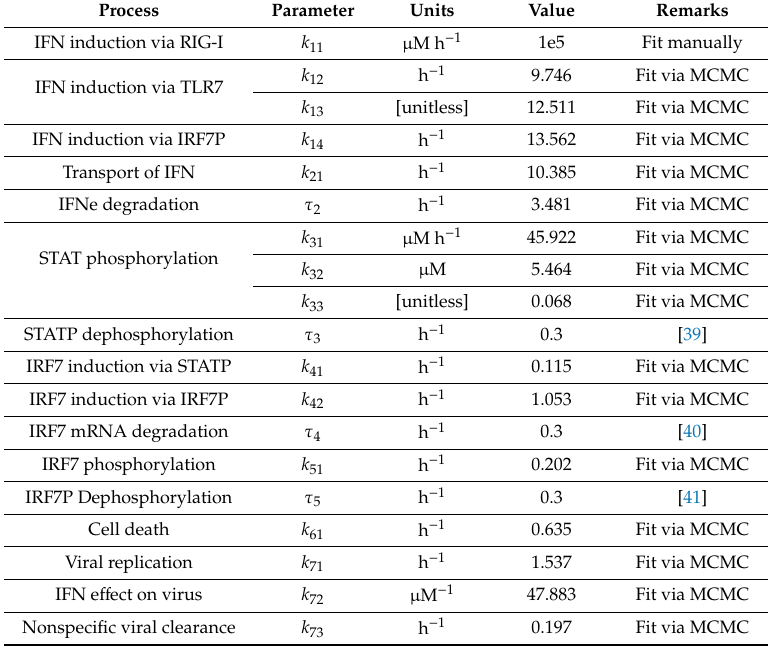
Table 1. Best-fit model parameters. All three MCMC runs converged to redundant parameter sets; these represent the minimum sum squared error (SSE) among all runs. Literature sourced values gave estimates for some species’ decay rates, which were not fit via MCMC.